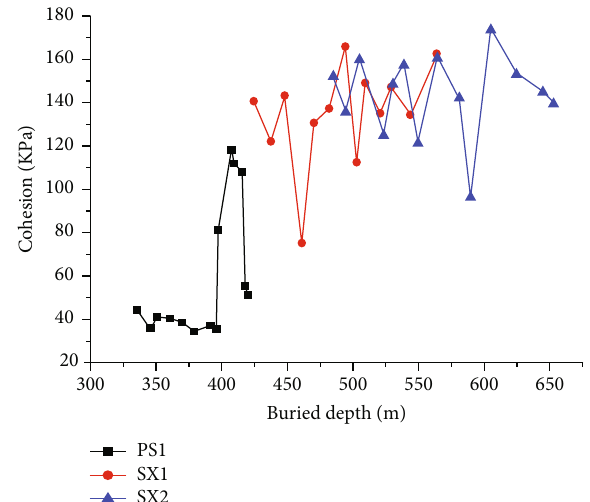
Figure 6: Curve of cohesion and depth of deep clay in Neogene.